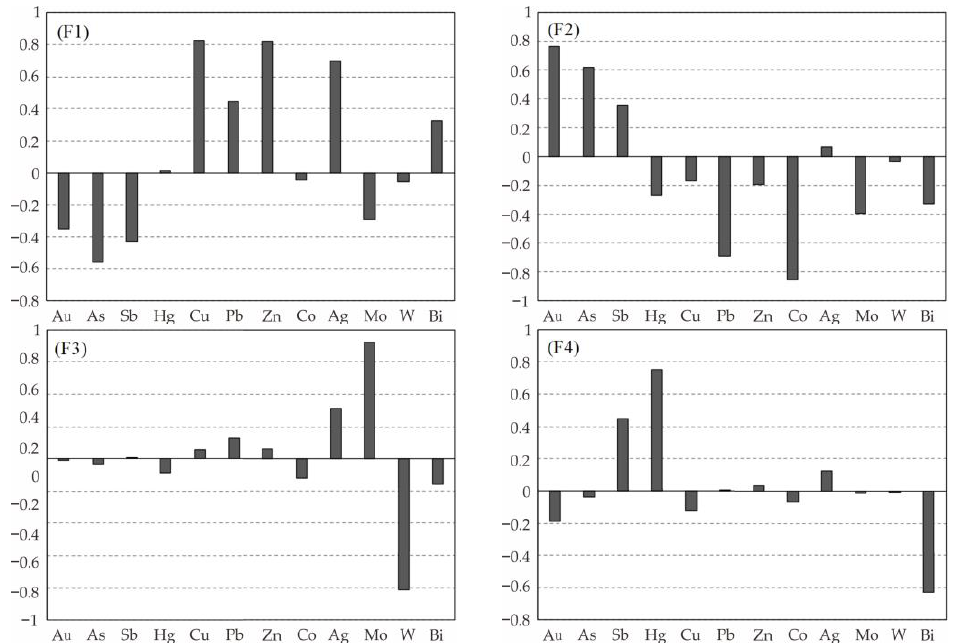
Figure 13. Distribution of element loadings in each factor.